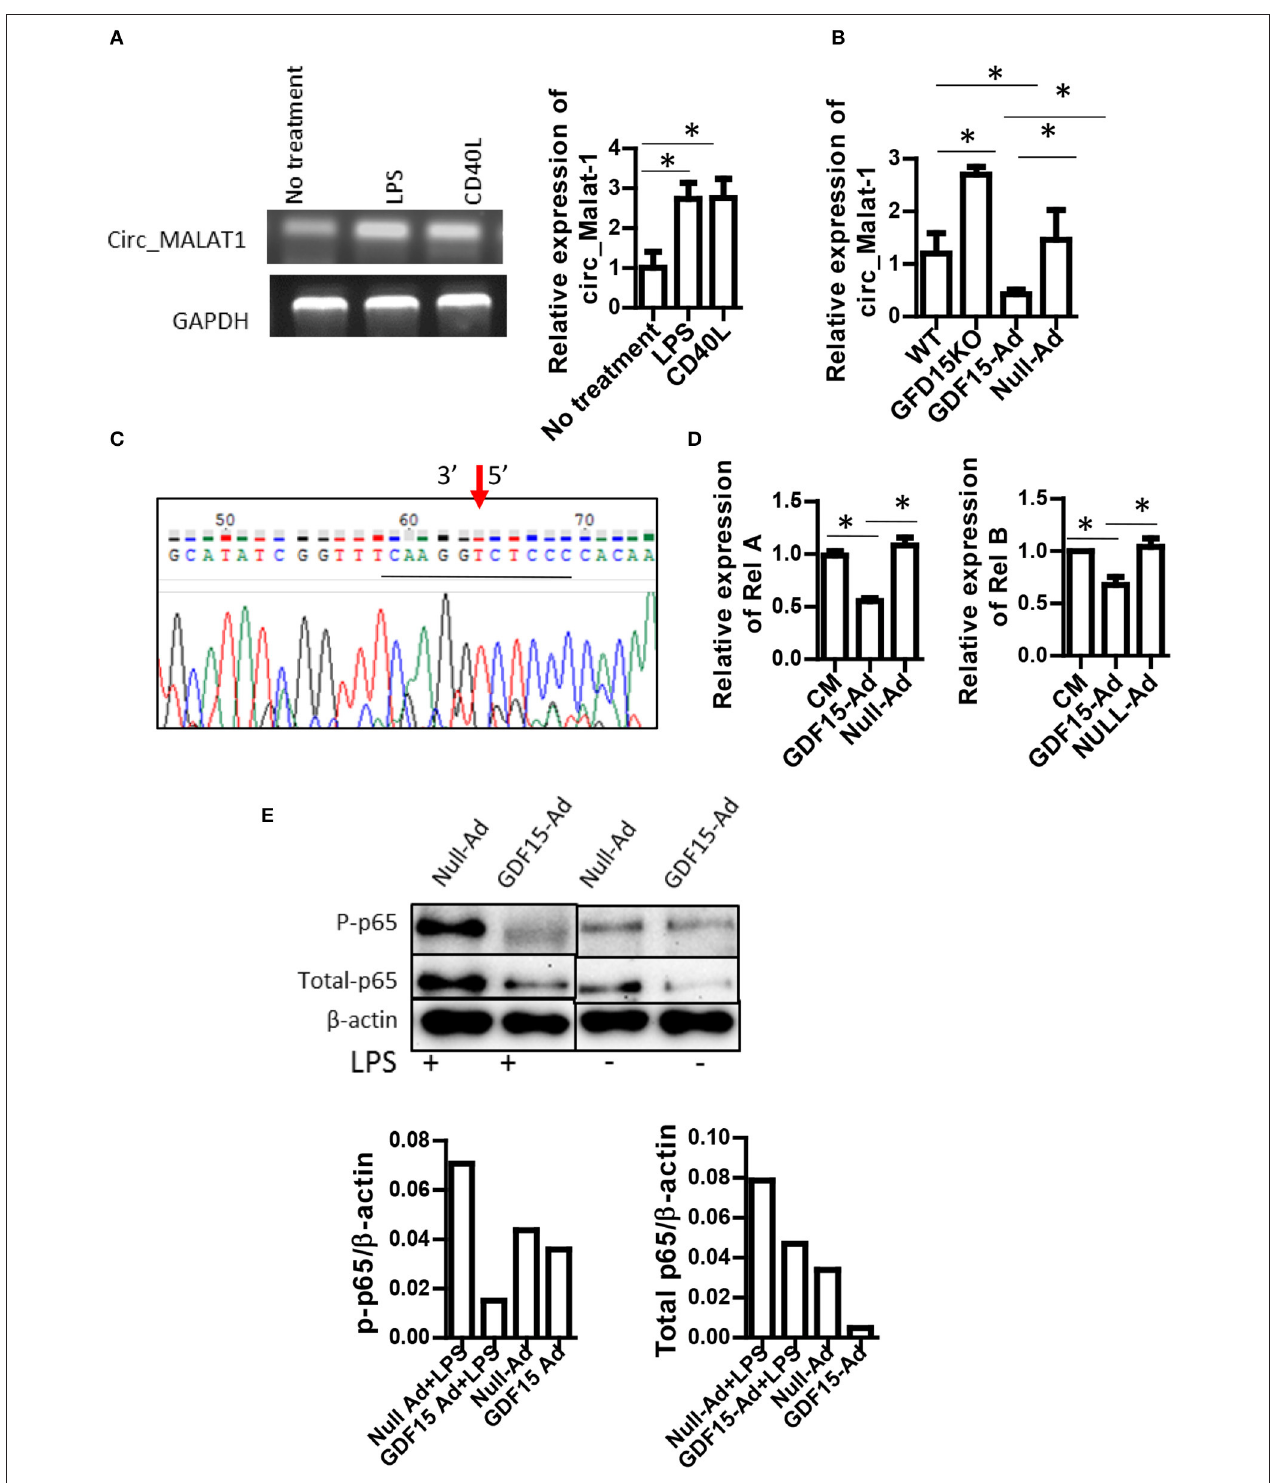
FIGURE 5 | GDF15 reduced circ_Malat-1 expression and inhibited the NF κ B pathway. (A) circ_Malat-1 expression in DCs. BM derived DCs were cultured from WT mice and treated with 50ng/ml CD40L or 10ng/ML LPS for 24h.Untreated DCs were used as control. RNA was extracted and circ_Malat-1 expression was detected by RT-PCR. Left: regular PCR, representative images for n = 3; Right: qPCR, n = 3, One way ANOVA was conducted for statistical analysis * P < 0.05. (B) GDF15